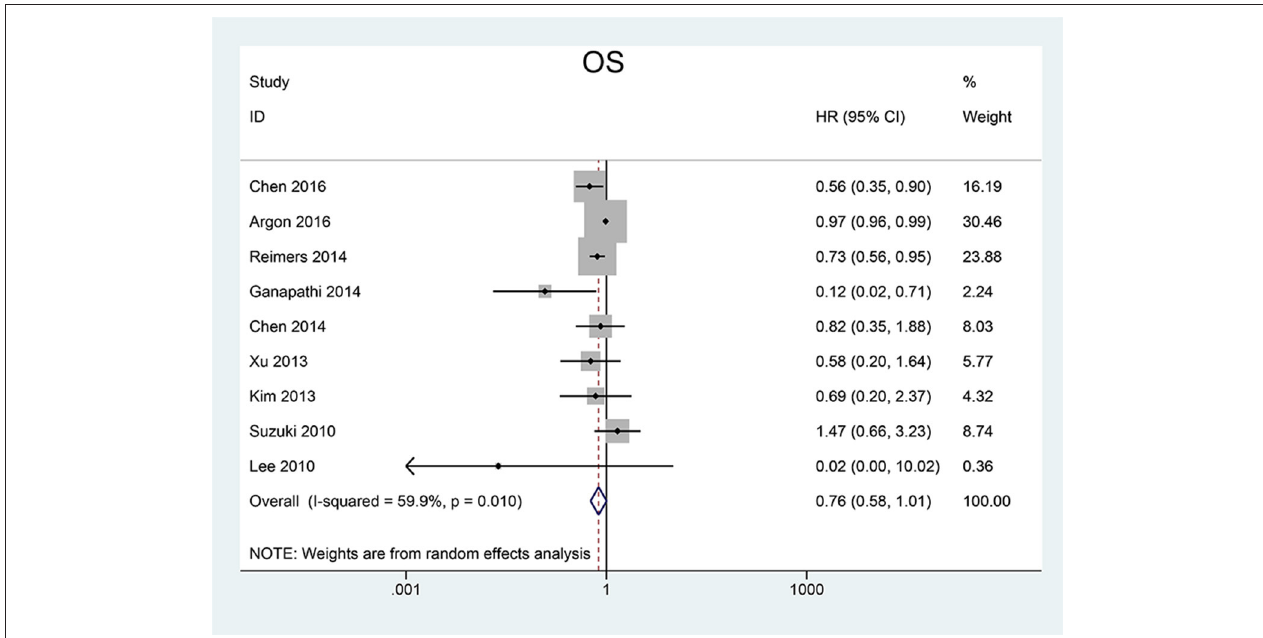
FIGURE 3 | Forest plot of the HR for the association between FoxP3 + Tregs and OS in patients with CRC. HR = 0.76, 95% CI = 0.58–1.01, P = 0.058, random model. FoxP3, Forkhead box P3; Tregs, regulatory T lymphocytes; CRC, colorectal cancer; OS, overall survival; HR, hazard ratio; CI, confidence interval.